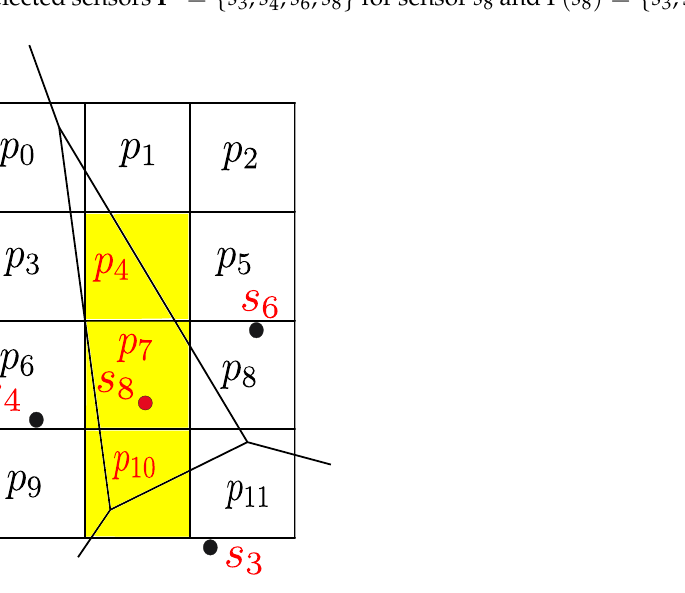
Figure 4. Voronoi diagram for the example presented in Tables 1 and 2. The center of the Voronoi cell is marked by red dot, while its natural neighbors are marked by black dots. Pixels whose centers are located within the Voronoi cell are colored in yellow. The extraction from the whole observed area is shown, where the pixels from p 0 to p 11 are